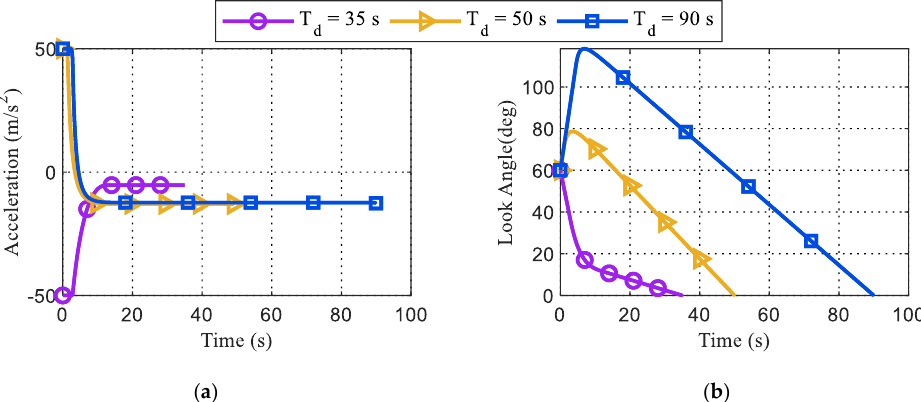
Figure 4. The results without look angle constraint. ( a ) Lateral acceleration; ( b ) Look angle.